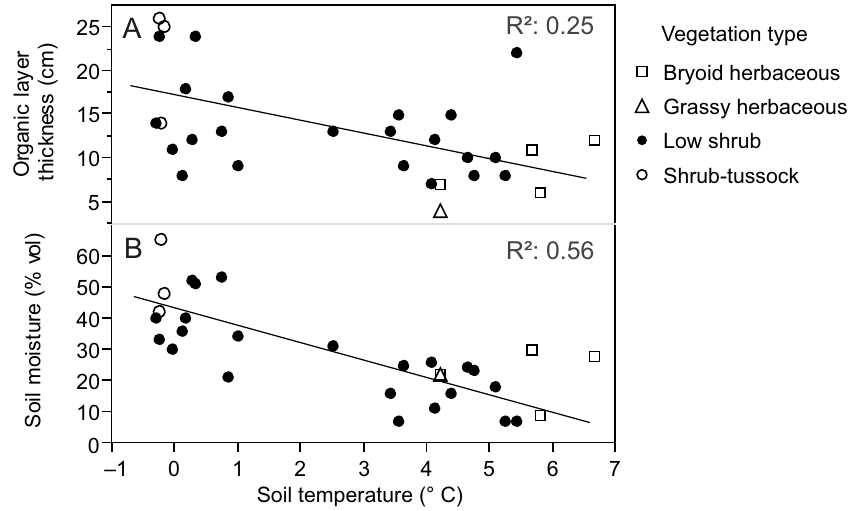
Figure 3. Relationships between soil temperature (1 m depth) and ( A ) organic layer thickness and ( B ) surface soil moisture (upper 20 cm), by vegetation type ( n = 30).